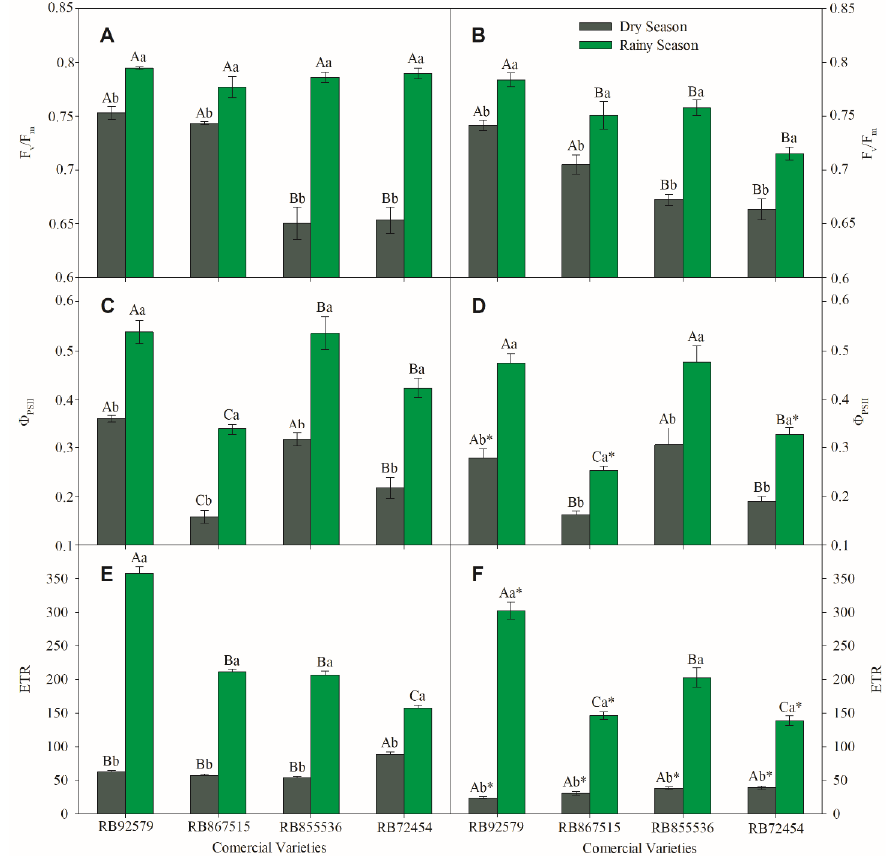
Figure 7. Variable-to-initial Chl fluorescence (F v /F m ; ( A , B )), the actual PSII efficiency during the exposure to sunlight ( Φ PSII ; ( C , D )), and electron transport rate (ETR; ( E , F )) measured in four varieties (RB92579, RB867515, RB855536, and RB72454) of sugarcane. The evaluations were made in dry season (gray bars) and rainy season (green bars) at 8:00 to 10:00 h ( A , C , E ) or at 12:00 to 13:00 h ( B , D , F ). Different lowercase letters denote significance within season for each variety, and different capital letters denote significance within varieties for the same season. An asterisk (*) denotes significance within 8:00 to 10:00 h and 12:00 to 13:00 h measurements in the same treatment.